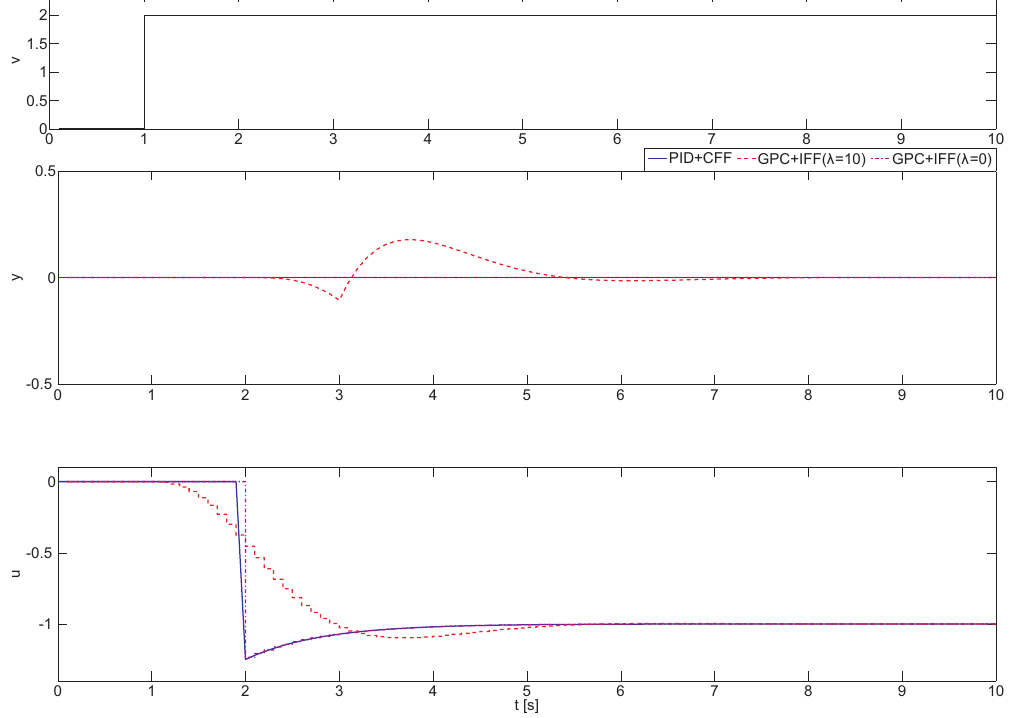
Figure 3. Comparison of compensation performance for the PID (Proportional - Integral - Derivative) and GPC (Generalized Predictive Control) approaches for realizable feedforward